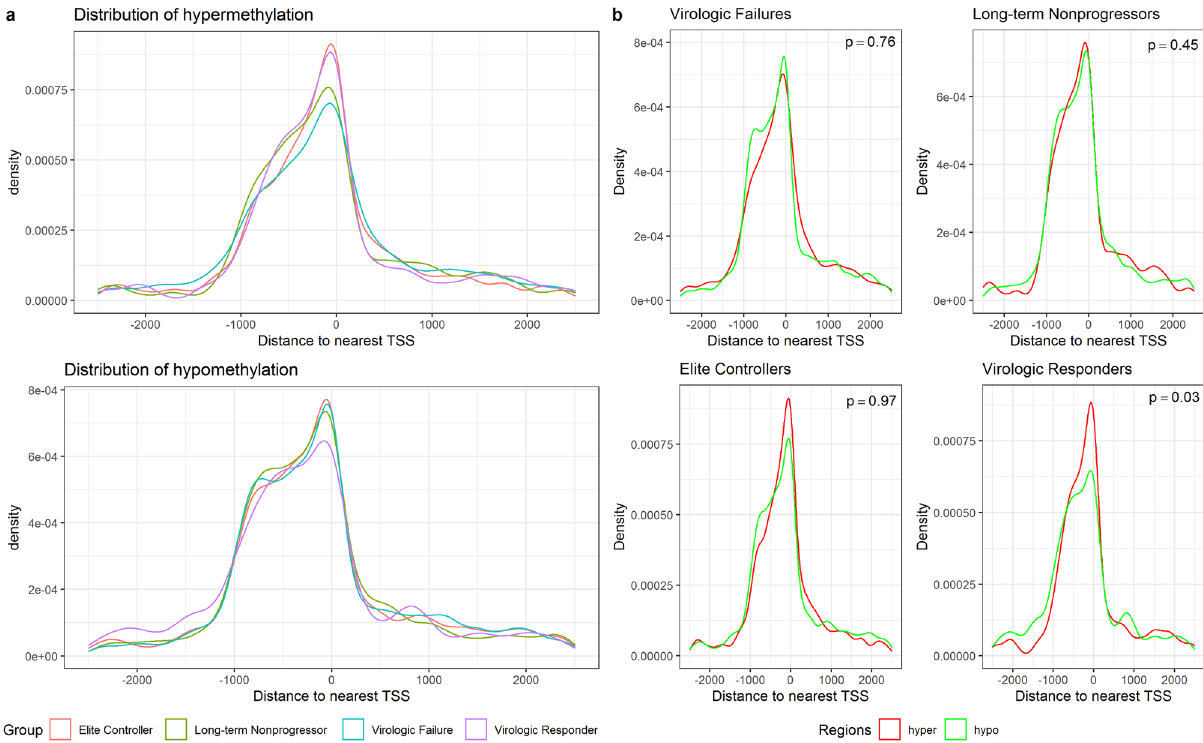
Figure 3. Distance from differentially methylated regions to nearest TSS in base pairs. ( a ) Distribution of hypo and hypermethylated regions in HIV-infected groups. ( b ) Intragroup comparison of hypo and hypermethylation distributions surrounding TSS for each HIV group (Wilcoxon rank-sum test). TSS Transcription Start